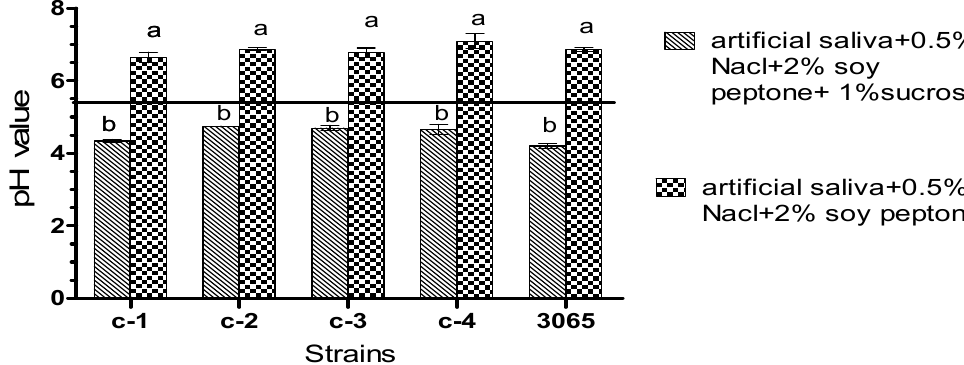
Figure 2. Sucrose-dependent acid production. The change of pH values after 24 h culture: 3065: S. mutans KCTC 3065; C-1: Streptococcus salivarius ; C-2: Streptococcus anginosus ; C-3: Leuconostoc mesenteroides ; C-4: Lactobacillus sakei . Black solid line: enamel demineralization critical pH. Vertical bars represent standard error of the mean ( n = 3), different letters in the same group indicate a significant ( p < 0.05) treatment effect.